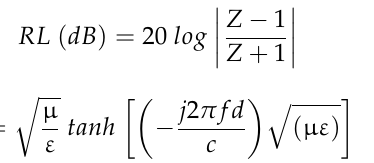
Figure 1. Schematic illustration of the combined destruction process.